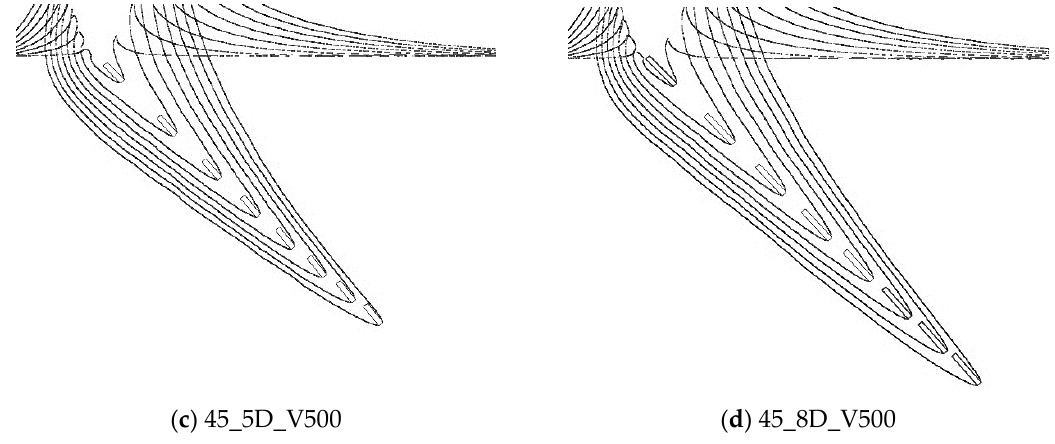
Figure 5. Evolution of water entry at initial angle 45 ◦ : ( a ) 45_5D_V100, ( b ) 45_8D_V100, ( c ) 45_5D_V500, ( d ) 45_8D_V500.